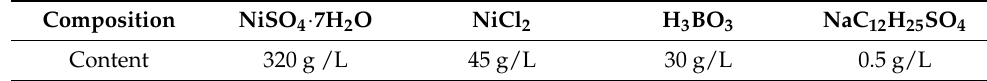
Table 2. Composition of the electroplating nickel bath.